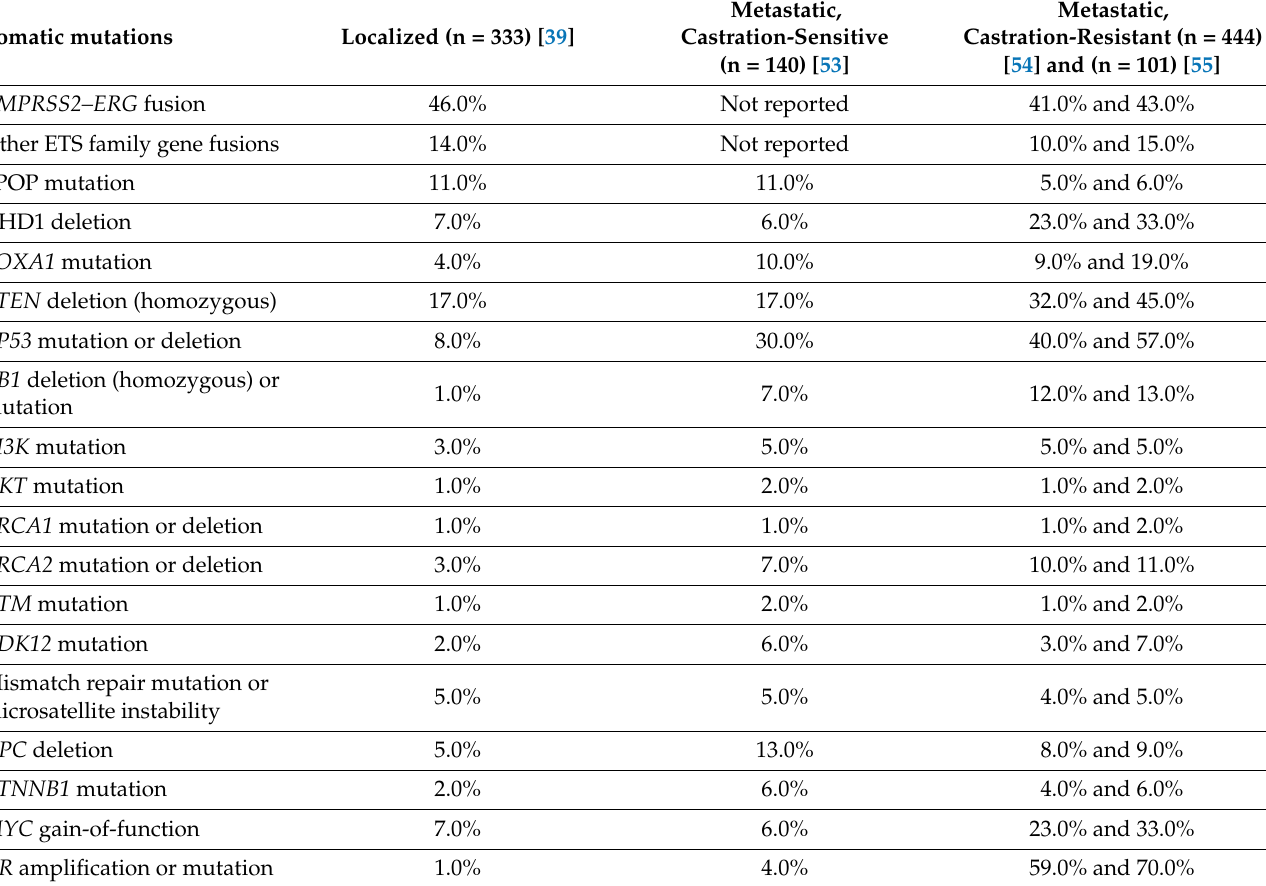
Table 1. Frequency of somatic and germline mutations by prostate cancer stage. Reprinted from the Lancet, 398, Sandhu et al., Prostate cancer, 1075–90 [4], Copyright 2021, with permission from Elsevier. * Castration sensitivity was not defined in this